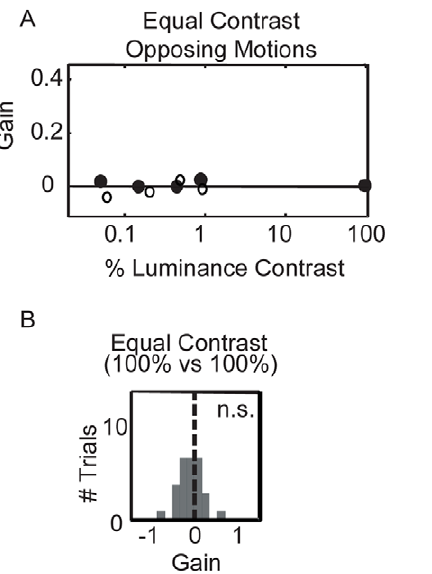
Figure 5. Oculomotor gain when opposing patterns are equal in contrast. A. The mean gain of the equal contrast conditions from Experiment 2 for Monkey A are plotted (filled circles) and Monkey B (open circles). Regardless of the actual contrast, at equal contrast, oculomotor gain is approximately zero. B. The distribution of gains resulting from opposing patterns both with 100% RMS-contrast (also plotted in panel A). The distribution is unimodal and is not significantly different from 0 (two-tailed t-test, p . 0.05).